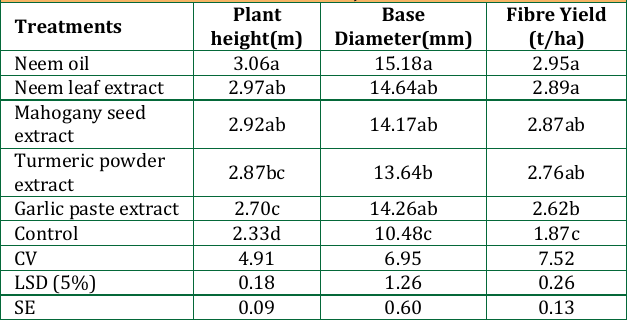
Table 4: Effect of different plant extracts on yield contributing characters of jute Treatments